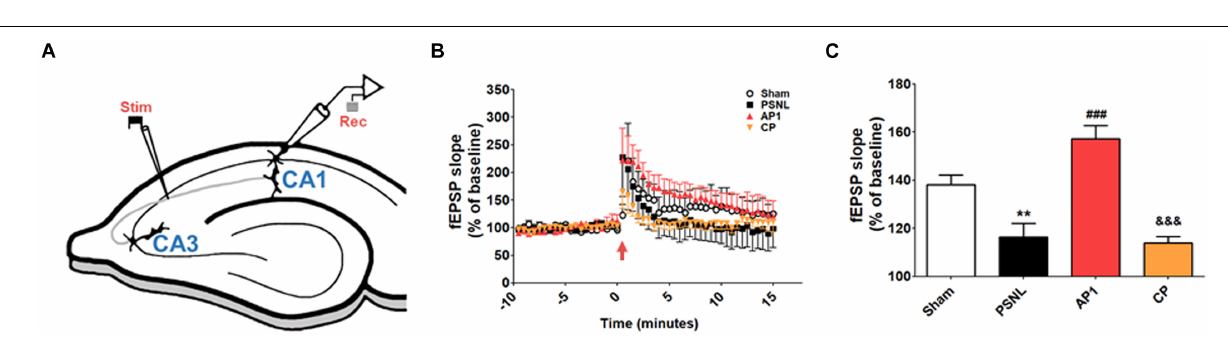
FIGURE 4 | Acupuncture increased fEPSP slopes in the hippocampal CA3 to CA1 areas of neuropathic pain model. A schematic of a transverse hippocampal area used in electrophysiology methods, showing recording (rec) and stimulating (stim) regions (A) . Averaged fEPSP data. High-frequency stimulation was given at 0 min, and the signal was followed for up to 15 min (B) . Summary of fEPSP slopes (from 0 to 15 min) shown in (C) . n = 5 in all groups. ∗∗ p < 0.01 vs. the Sham groups. ### p < 0.001 compared with the PSNL group, and &&& p < 0.001 vs. AP1 group. The data were analyzed with a one-way ANOVA followed by Newman–Keuls post hoc tests. The results are expressed as the mean ± SEM. AP1, acupuncture 1 (GB30 and GB34); AP2, acupuncture 2 (HT7 and GV20); CP, control